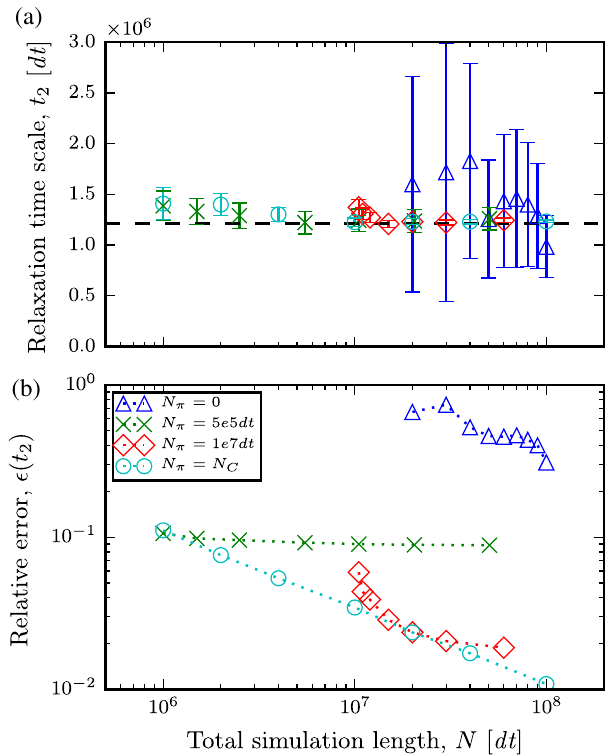
FIG. 4. Mean and standard error of largest implied time scale t 2 , given total simulation effort N , for Brownian dynamics in double- well potential. (a) Convergence of the mean value, using either a single long trajectory starting in one of the metastable states or the equilibrium distribution together with an ensemble of short chains relaxing from the transition state. The latter approach allows us to obtain a reliable estimate before the average waiting time for a single rare event τ AB þ τ BA has elapsed. A comparison of the standard error (b) indicates a more than 2 orders of magnitude speed-up when estimating the rare-event sensitive quantity t 2 . By combining short trajectories with information about the equilibrium probabilities, reliable estimates of the slowest relaxation time scale can be obtained with a total amount of simulation data that is about 1 order of magnitude smaller than the expected waiting time for a forward and backward transition across the